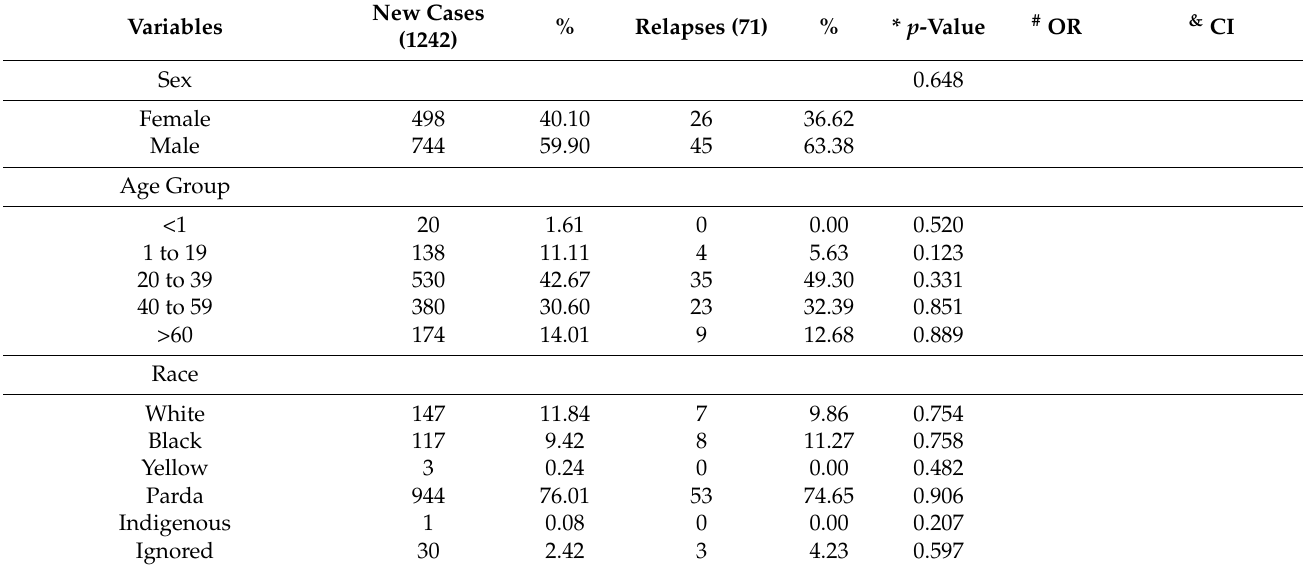
Table 3. New cases versus relapses profile in Ananindeua, Par á from 2018 to